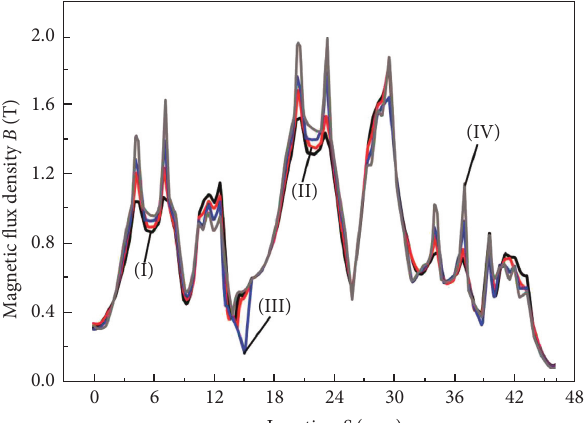
Figure 9: Distribution of magnetic field in smaller radial clearance under different eccentricity of rotating shaft (I), 0; (II), 0.1/13.6; (III), 0.2/ 13.6; and (IV), 0.3/13.6.